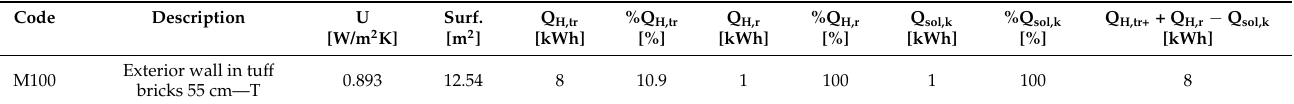
Table 5. Dispersions through the M100 component: ante operam monitoring period; climatic zone